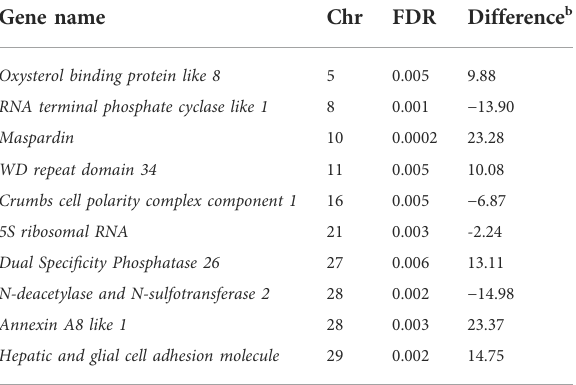
TABLE 2 Top 10 differentially methylated promoter a regions of genes in amygdala of prenatally stressed mature Brahman cows relative to Control